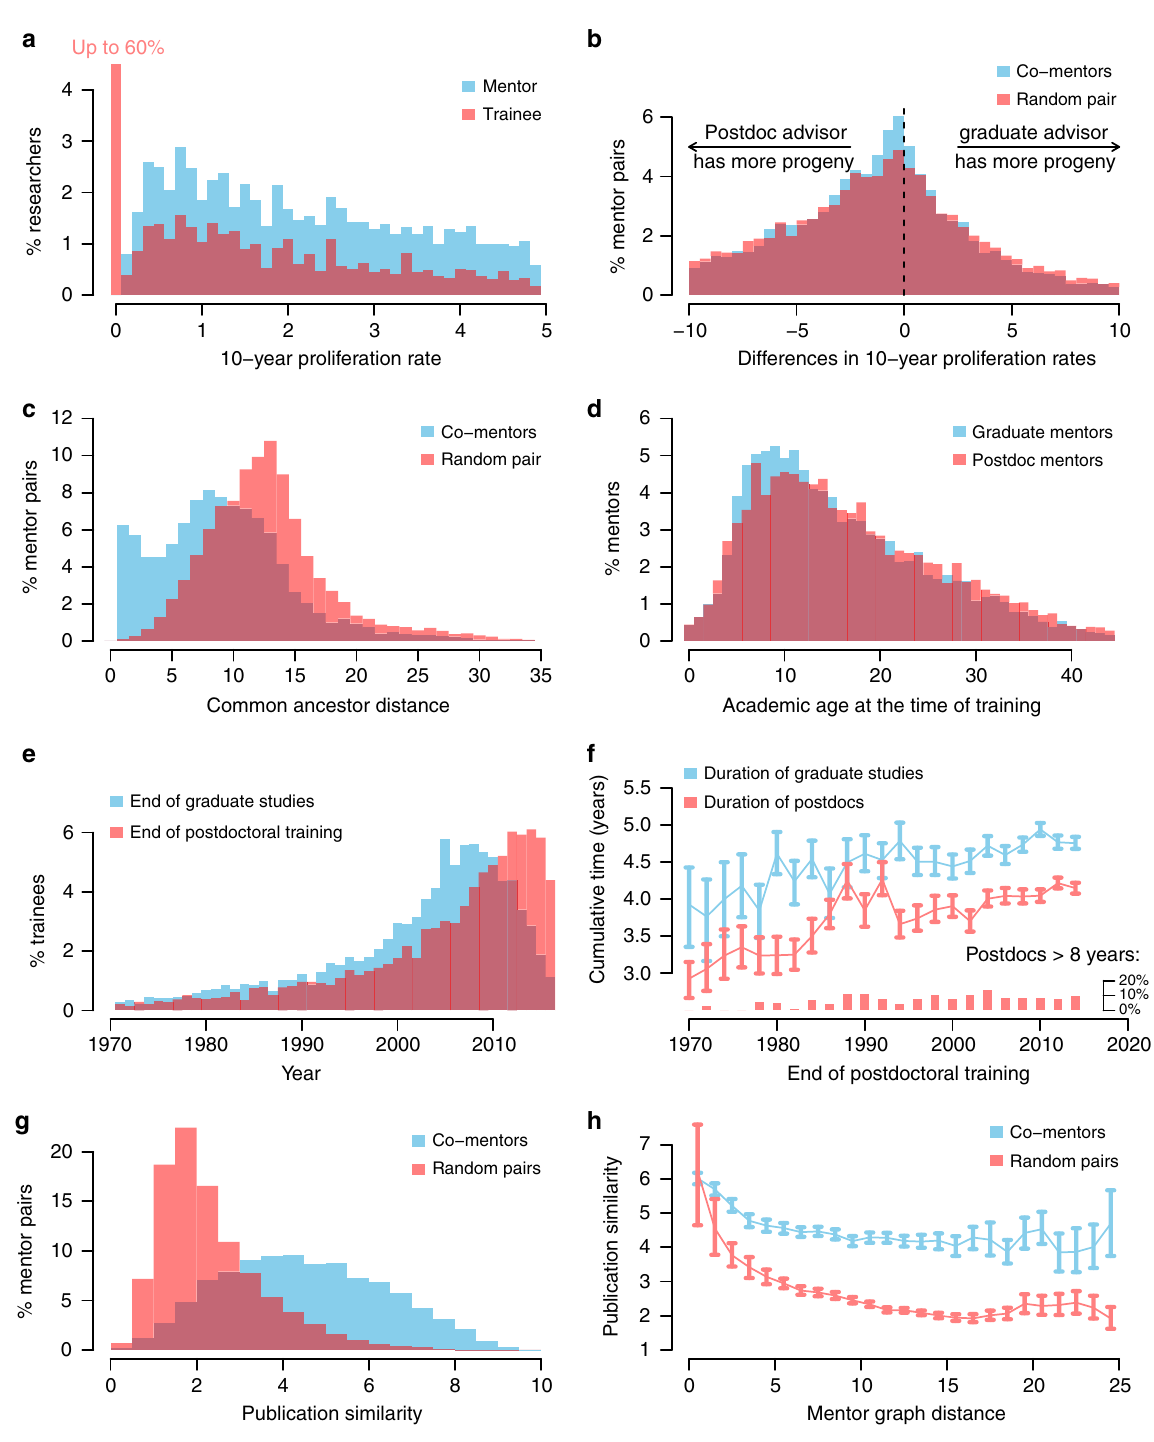
Fig. 2 Main features of the n = 18,856 mentorship triplets in life science analyzed in this study. Each triplet is constituted by a pair of graduate and postdoc mentors and their common trainee. a Distribution of proliferation rate (average number of trainees per decade) of mentors (blue) and trainees (red). The large peak at zero for trainees re fl ects the large number of trainees that do not go on to mentor students of their own. b Difference in proliferation rate between graduate and postdoc mentors common to triplets (blue) and mentor pairs picked at random (red). c Common ancestor distance of co-mentors (blue) and mentors picked at random. d Academic age at the time of training for graduate and postdoc mentors of each triplet. e Year of graduation (blue) and end of postdoc (red) for triplets. The decreasing number of trainees graduated in recent years, in blue, results from the inclusion criterion of trainees that were selected as those having undergone postdoctoral training. f Mean cumulative time spent in graduate studies (blue) and postdoctoral fellowships (red), as a function of postdoc end date. Postdoctoral studies lasting more than 8 years were excluded from the computation of cumulative time. Instead their proportion was plotted as bars at the bottom the graph. g The similarity between co-mentors (blue) is higher than among a randomly picked pair of researchers (red). h Closer common ancestor distance leads to greater publication similarity, and this effect is cumulative with the higher proximity